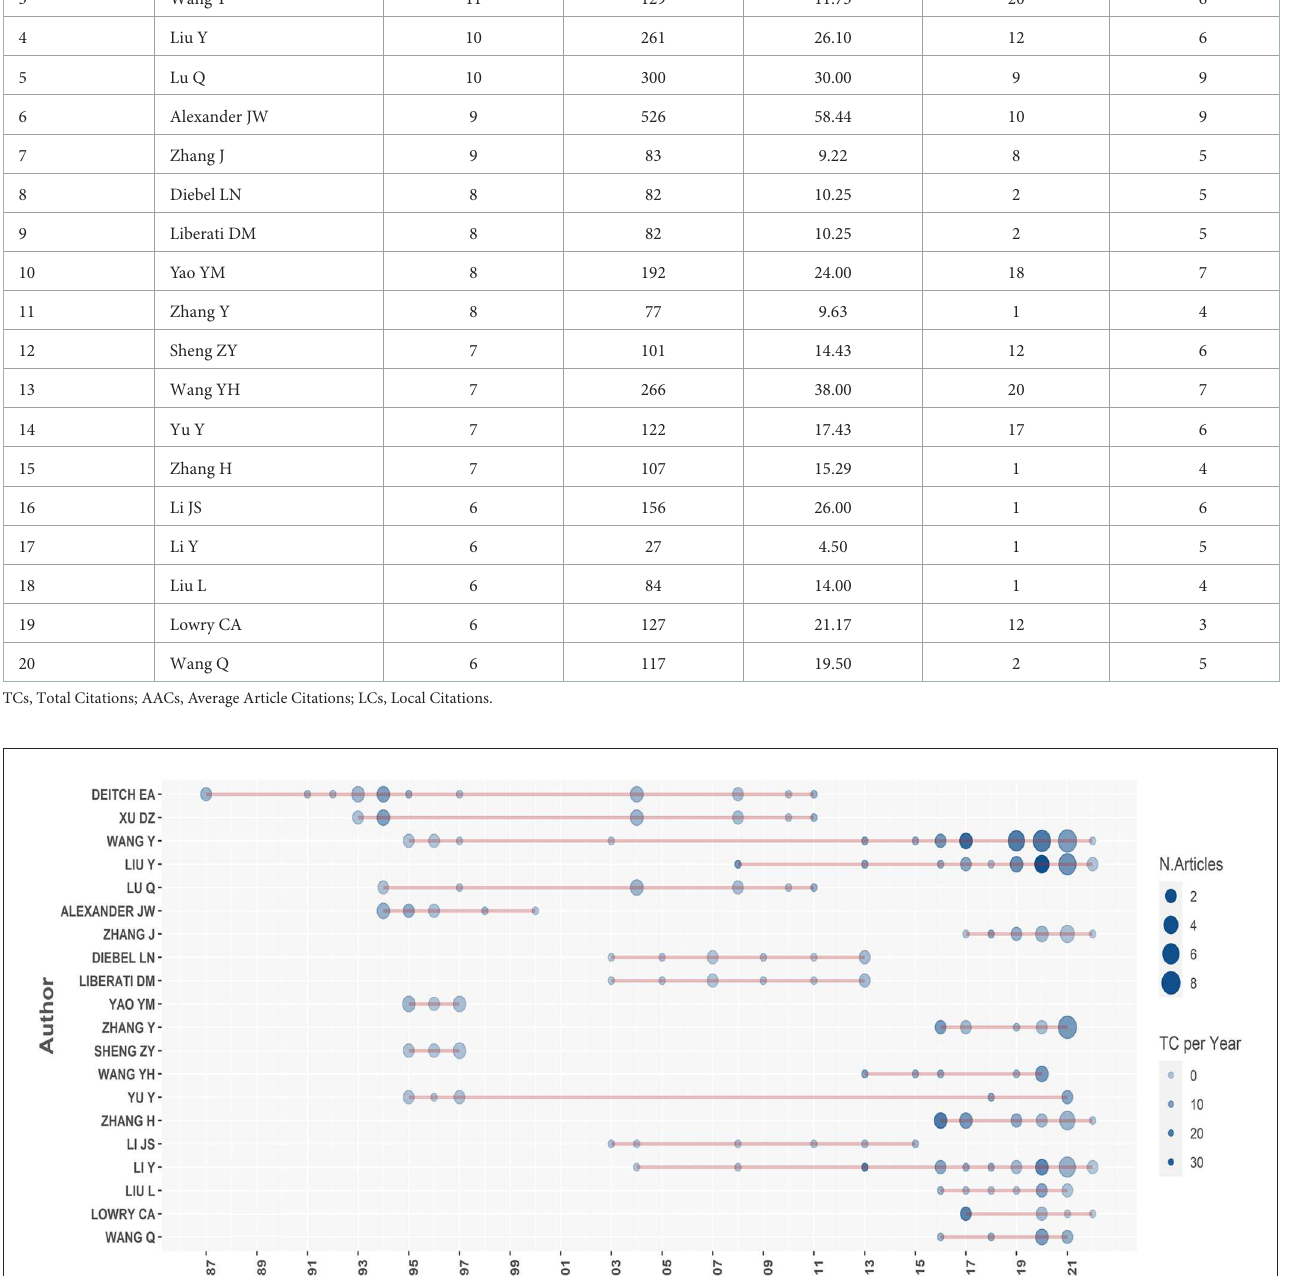
(TS = microflora) OR (TS = bacteria) OR (TS = prebiotic) OR (TS = probiotic)]. The visualized results of the new retrieval data were exposed in Supplementary Figures S7, S8. The growth trend of annual publication, the top 5 most prolific countries,